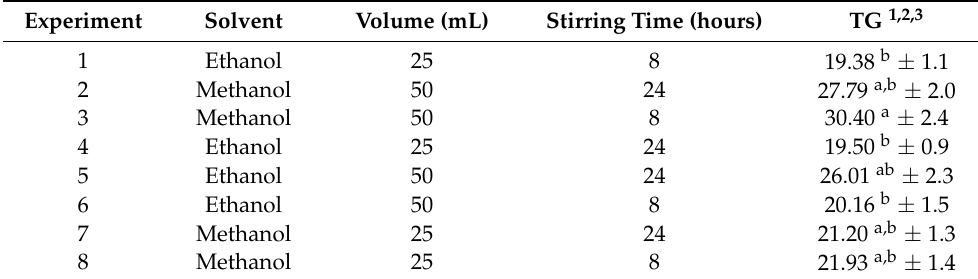
Table 1. UPLC-DAD quantification of 6-gingerol, 8-gingerol and 10-gingerol in Z. officinale sample NR-1 under various solvents, extraction volumes and stirring time